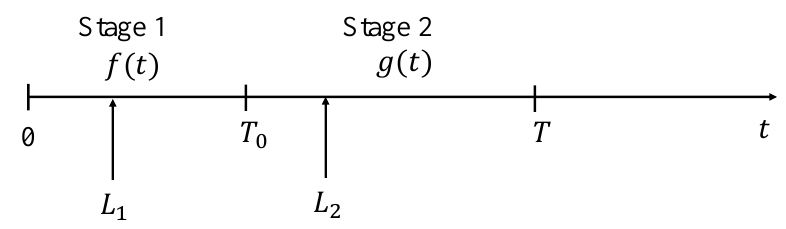
Figure 1. Two-stage intervened decision making process